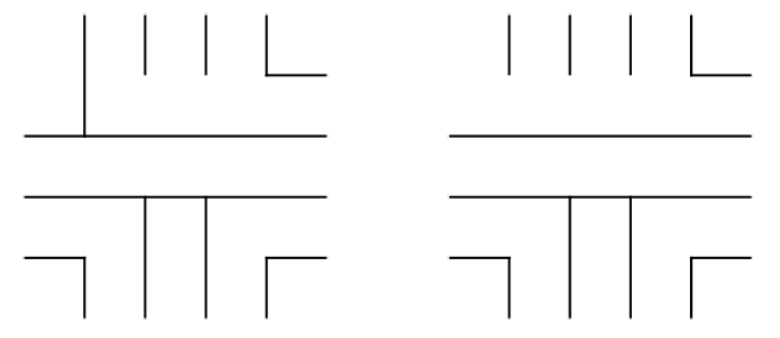
Figure 3 . Two trivial centers of gauge (cid:12)elds with Coulomb gauge. The (cid:12)gures are corresponding to square regions of size n = 3. Because of the redundancy of gauge (cid:12)elds, we have to (cid:12)x some operators on the links to get the physical degrees of freedom. For every vertex, we can (cid:12)x a link connected to it, but we can not (cid:12)x a loop. We remove the (cid:12)xed link in the above two (cid:12)gures. The left (cid:12)gure corresponds to the algebra of full trivial center, where we keep all the physical degree of freedom. We denote it as A . The right (cid:12)gure corresponds to the algebra of trivial center with one physical degree of freedom removed. We denote it as ^ A .